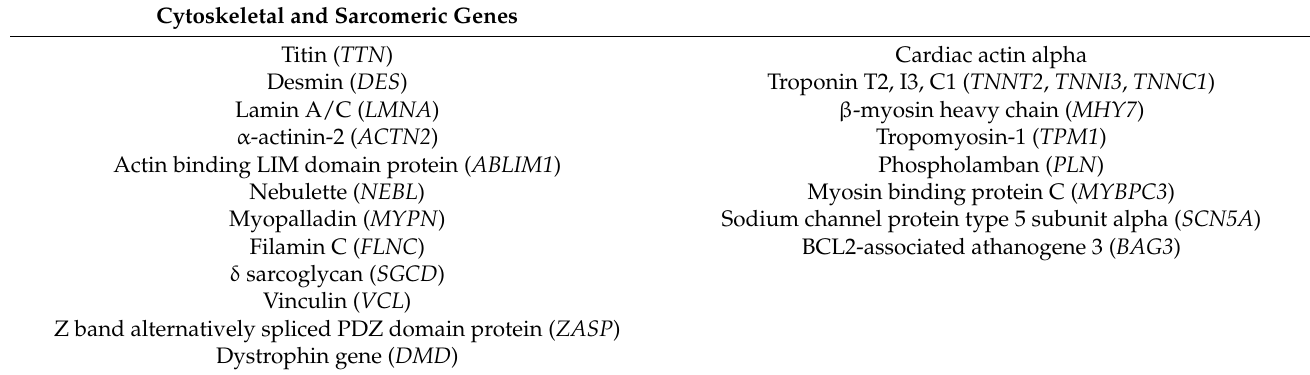
Table 2. Mutations in cytoskeletal and sarcomeric protein-coding genes are majorly associated with DCM